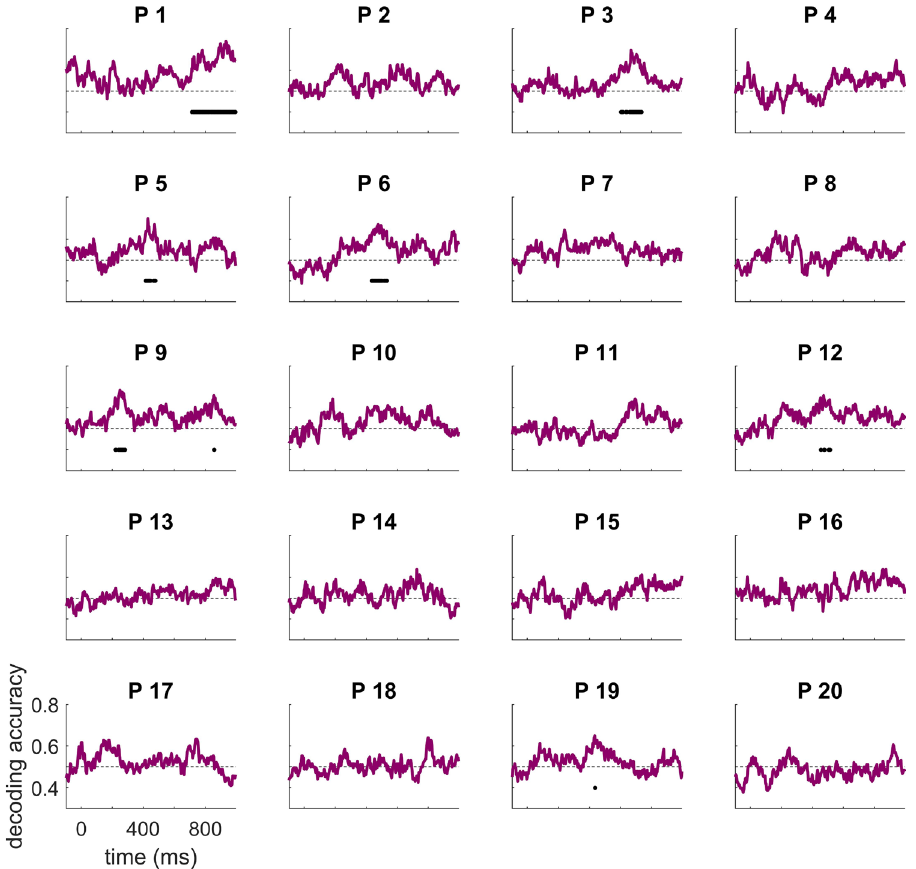
Figure 3. Individual time-resolved decoding accuracies. Chance (50%) is indicted by the horizontal dashed line. Accuracy significantly above chance is indicated by a solid black horizontal line for each participant (after multiple comparison correction). Participant numbering as in Fig. 2, seven participants had decoding accuracy significantly above